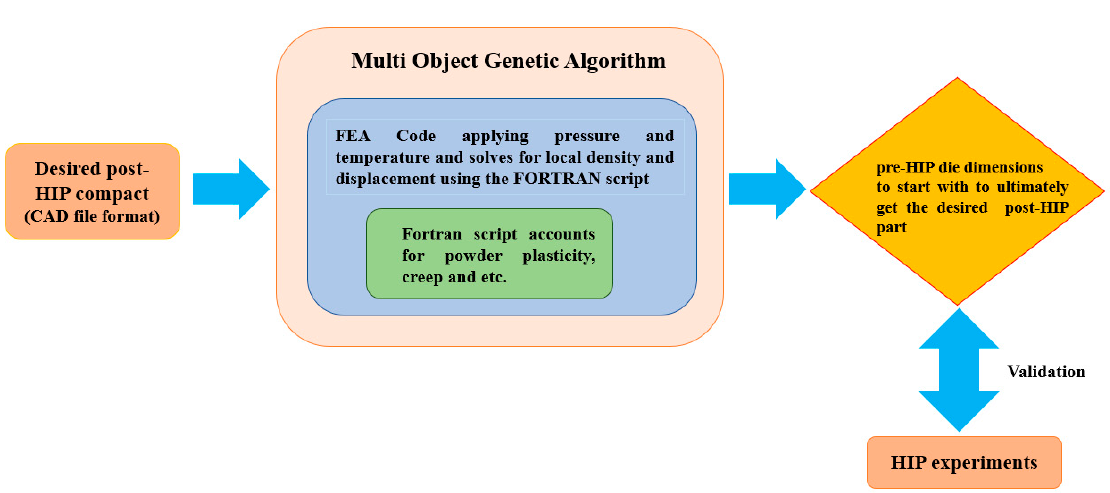
Figure 1. The developed modeling